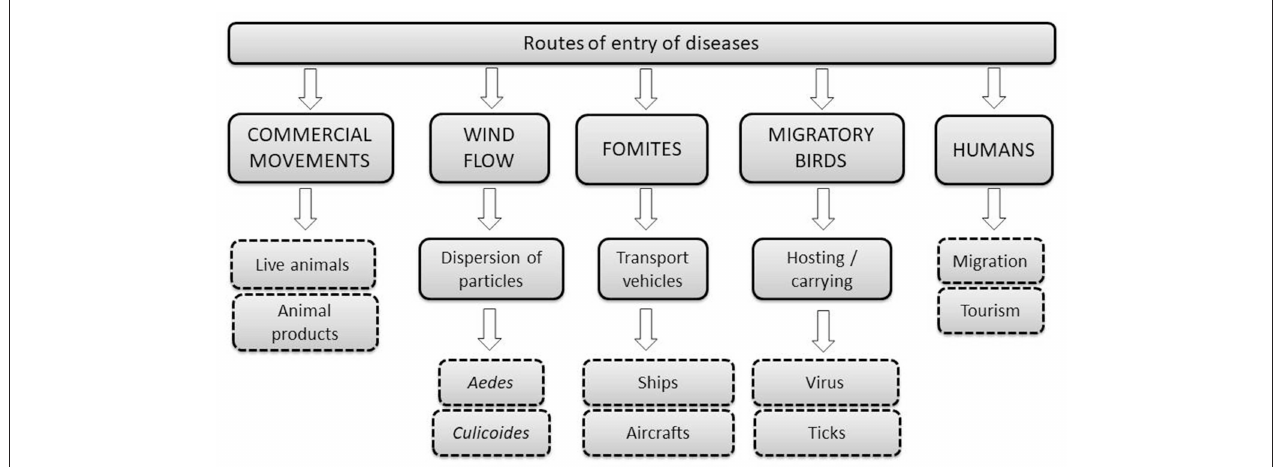
FIGURE 1 | Major routes of entry of diseases from North Africa and Middle East in the European